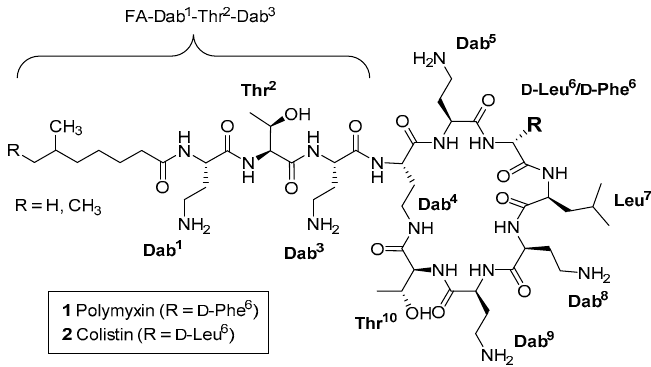
Figure 1. Structures of polymyxin B 1 and polymyxin E (colistin) 2 .